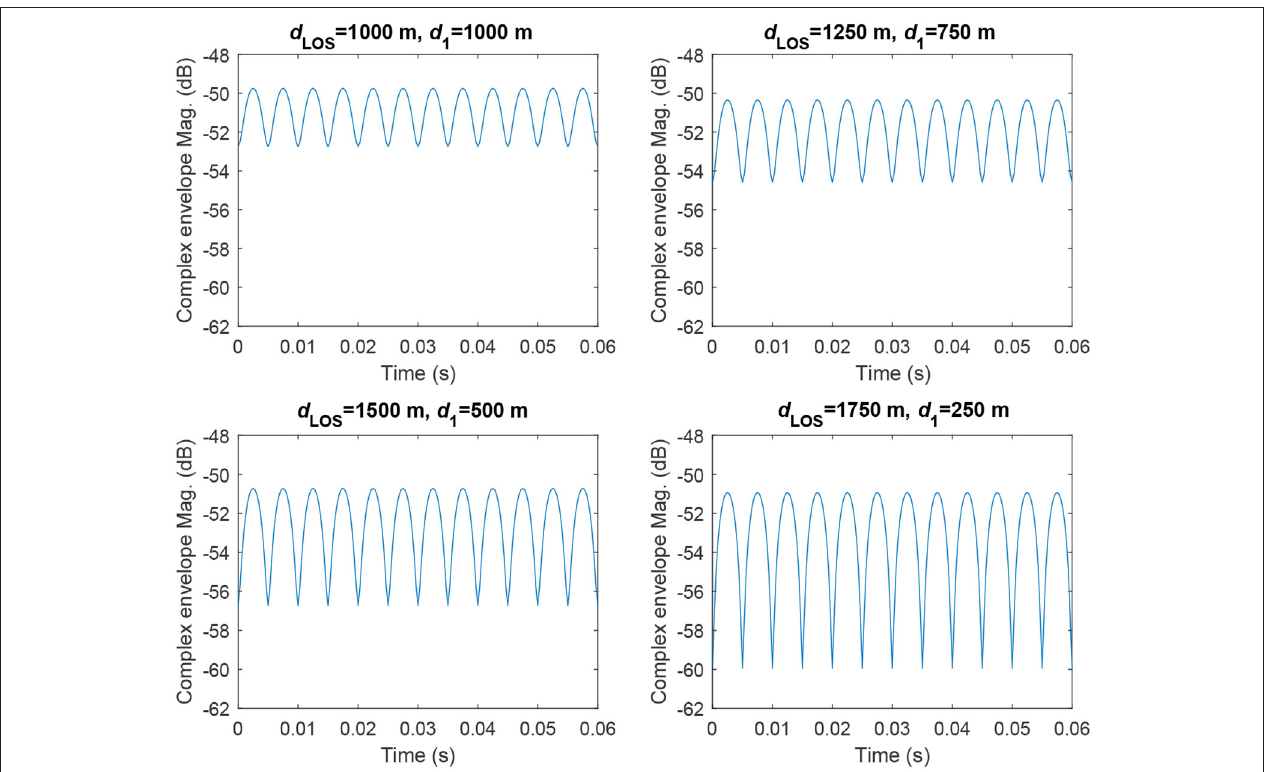
FIGURE 2 | Complex envelope variation with respect to MS movement with V = 10 m/s for varying d LOS and d 1 (observation interval: 0.06 s, traveled distance: 6 λ = 0.6